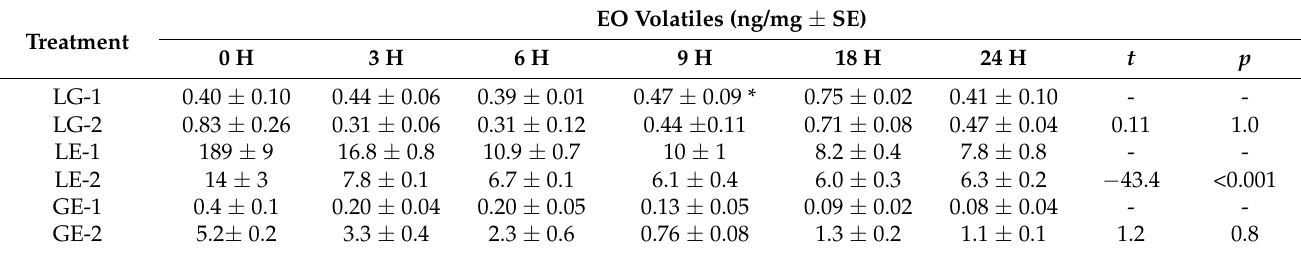
Table 3. Mass (ng) of essential oil (EO) volatiles per mg of inclusion complex ± standard error (SE) released at 0, 3, 6, 9, 18, and 24 h. Inclusion complexes were stored on a watch glass at 10–20% humidity and room temperature for the indicated times. Volatiles released by 10 mg (lemongrass (LG) and geranium Egyptian (GE)) or 5 mg (lemon eucalyptus (LE)) of inclusion complexes in 20 mL vial were analyzed by SPME/GC-MS and quantified using liquid standard curves of respective essential oil in hexanes.